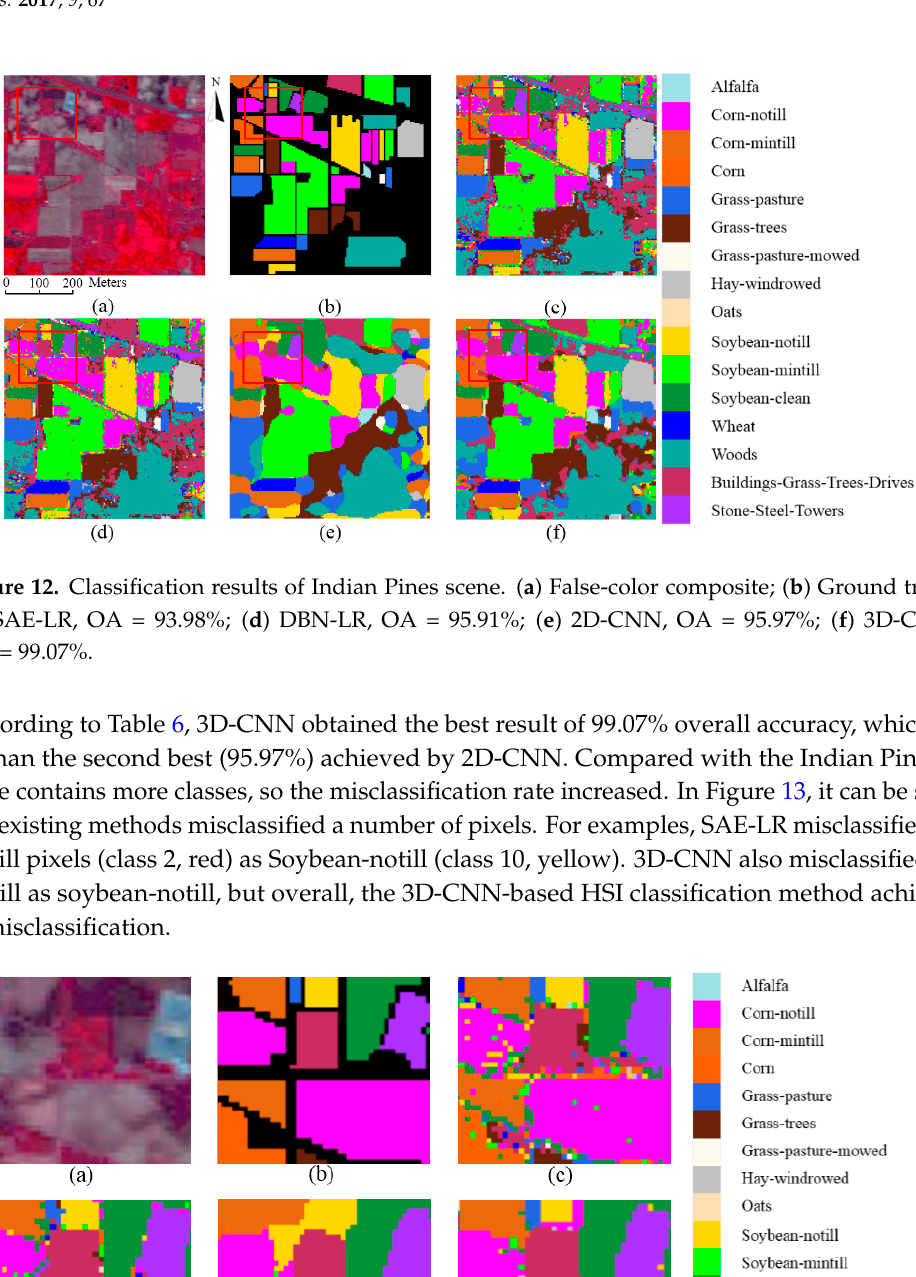
16 Table 9. Classification results (%) of Indian pines scene. Methods Class